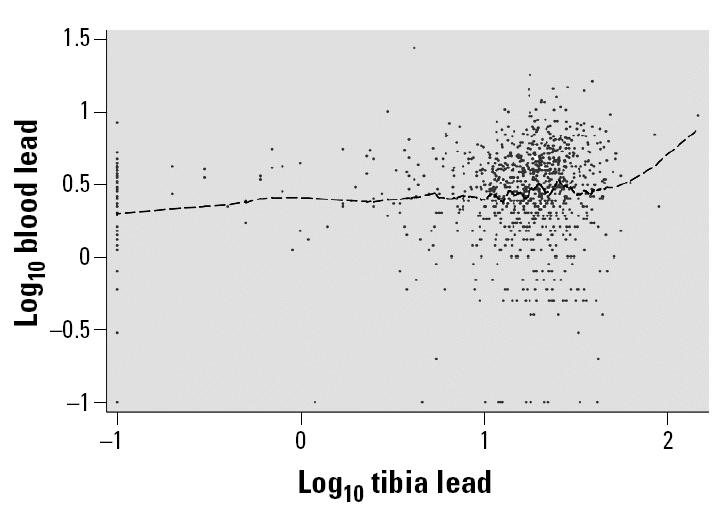
Crude relation of log10-transformed blood lead levels and log10-transformed tibia lead levels for 955 participants in the Baltimore Memory Study. Dashed line represents a locally weighted smoothing fit (lowess bandwidth, 0.10) (Cleveland 1979).